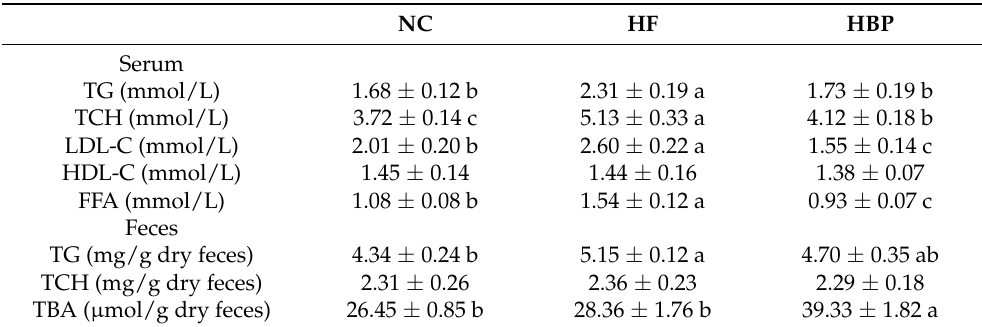
Table 2. Effects of a 14-week treatment with hydrolyzed bound phenolics from rice bran on serum and fecal lipid profiles of C57BL/6J mice fed a high-fat diet.